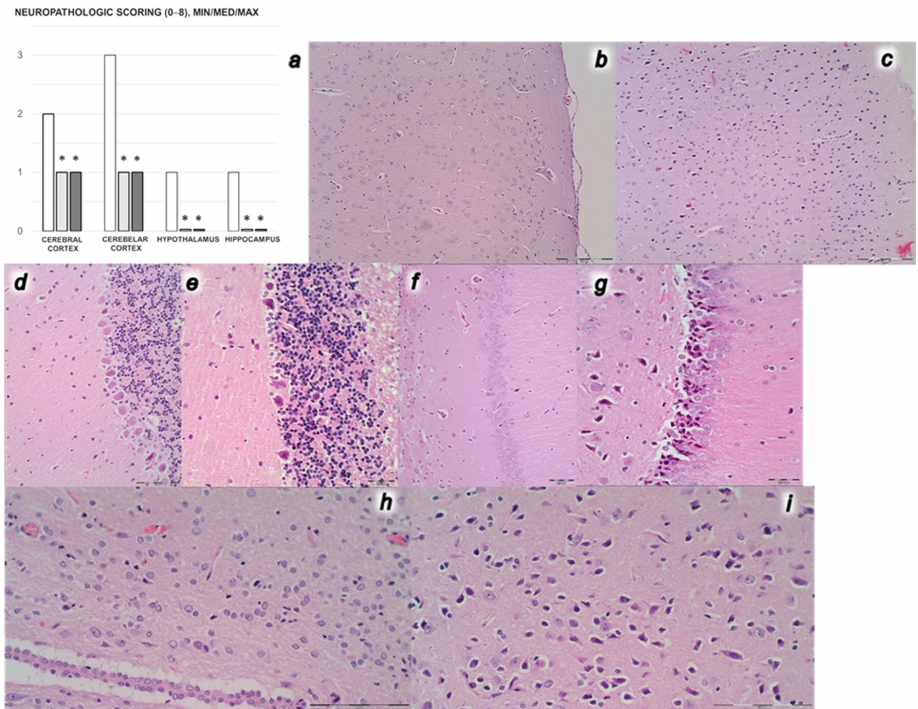
Figure 10. Microscopy scoring of the lesions of the brain lesions ( a ) (cerebral and cerebellar cortex, hypothalamus, hippocampus neuropathologic scoring (0–8)), Min/Med/Max, at the end of the 30 min period following medication (BPC 157 10 µ g/kg (light gray bars), 10 ng/kg (dark gray bars); saline 5 mL/kg (white bars)) given intraperitoneally. Six rats/group/interval. * p < 0.05, at least vs. control. Characteristic microscopy presentation of the affected brain ( b – i ). Cortex ( b , c ). Edema and hypoxia in controls ( c ), unlike BPC 157 rats ( b ). Cerebellum ( d , e ). Purkinje cells hypoxia in controls ( e ), unlike BPC 157 rats ( d ). Hippocampus ( f , g ). Hypoxia and red neurons ( g ), unlike BPC 157 rats ( f ). Hypothalamus ( h , i ). Hypoxia and red neurons in controls ( i ), unlike BPC 157 rats ( h